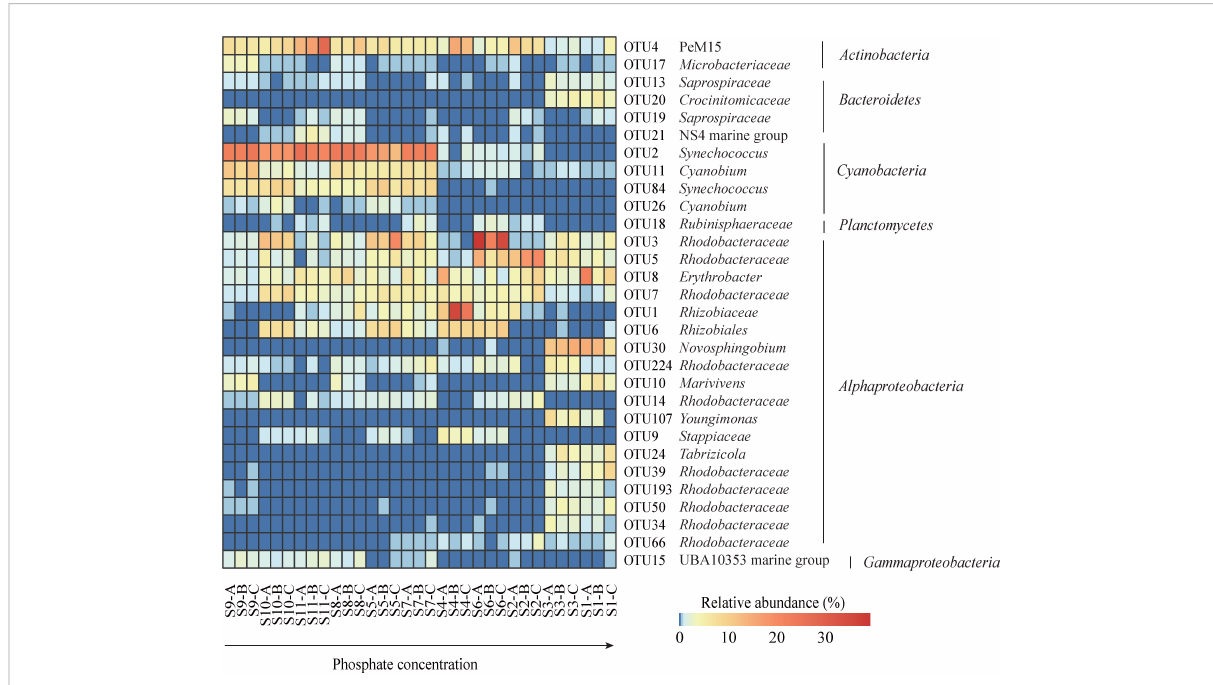
FIGURE 4 The distributions of the top 30 OTUs along the phosphate gradient in the Daya Bay.